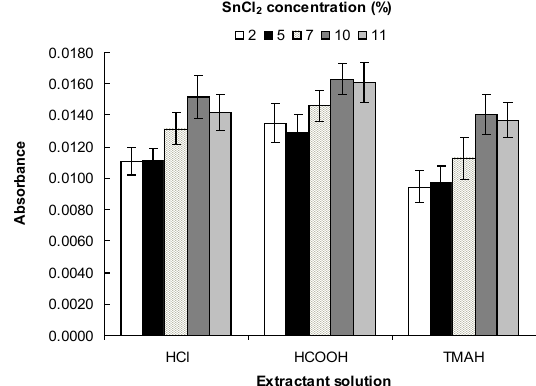
SnCl 2 concentration (%)